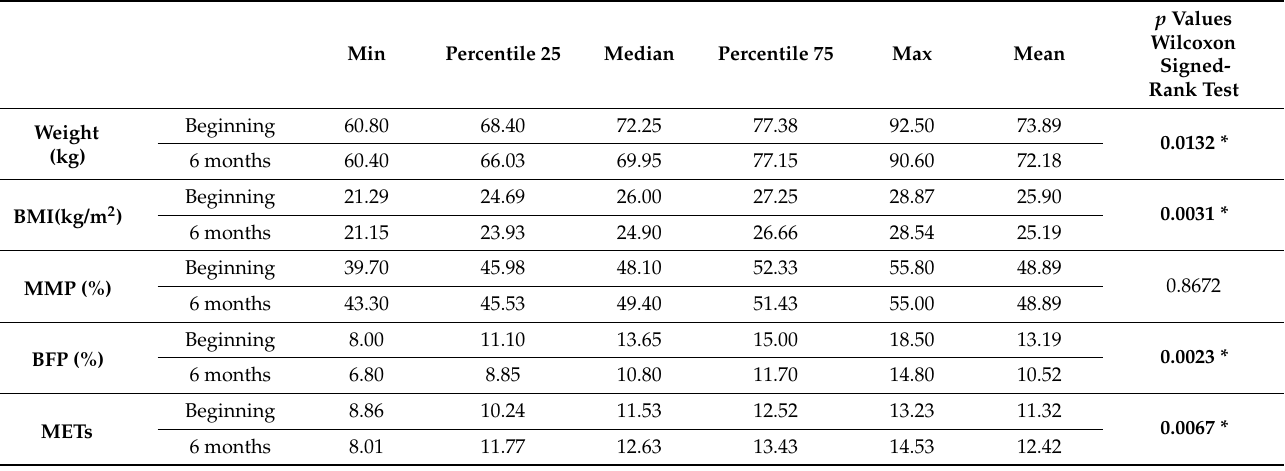
Table 3. Descriptive statistics of SHRSs’ characteristics at the beginning and after 6 months of